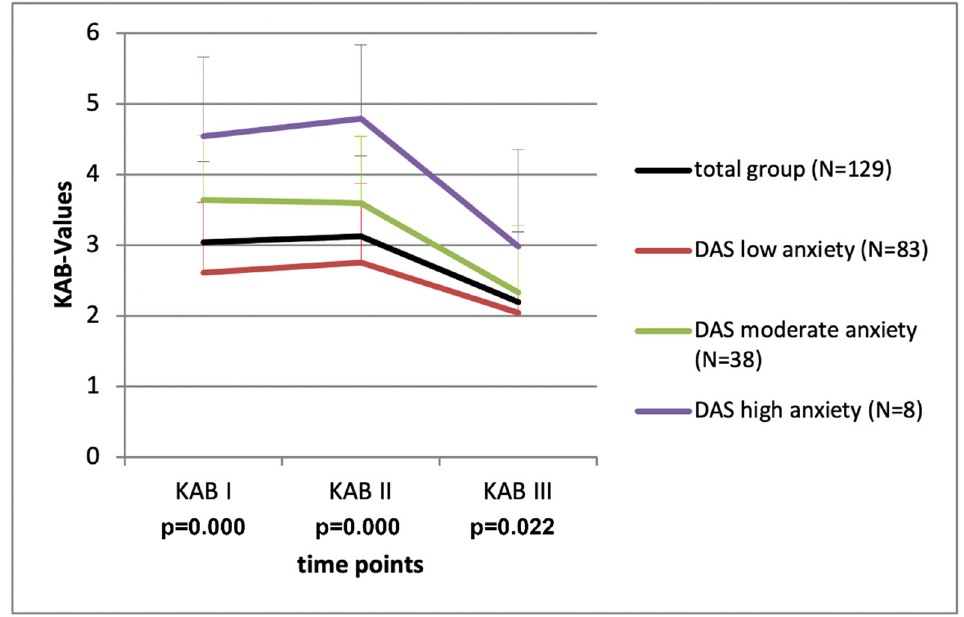
Figure 1. Stress of the patients (means ± standard deviations, KAB) at three different times in dependent on the level of anxiety (DAS) of the patients.